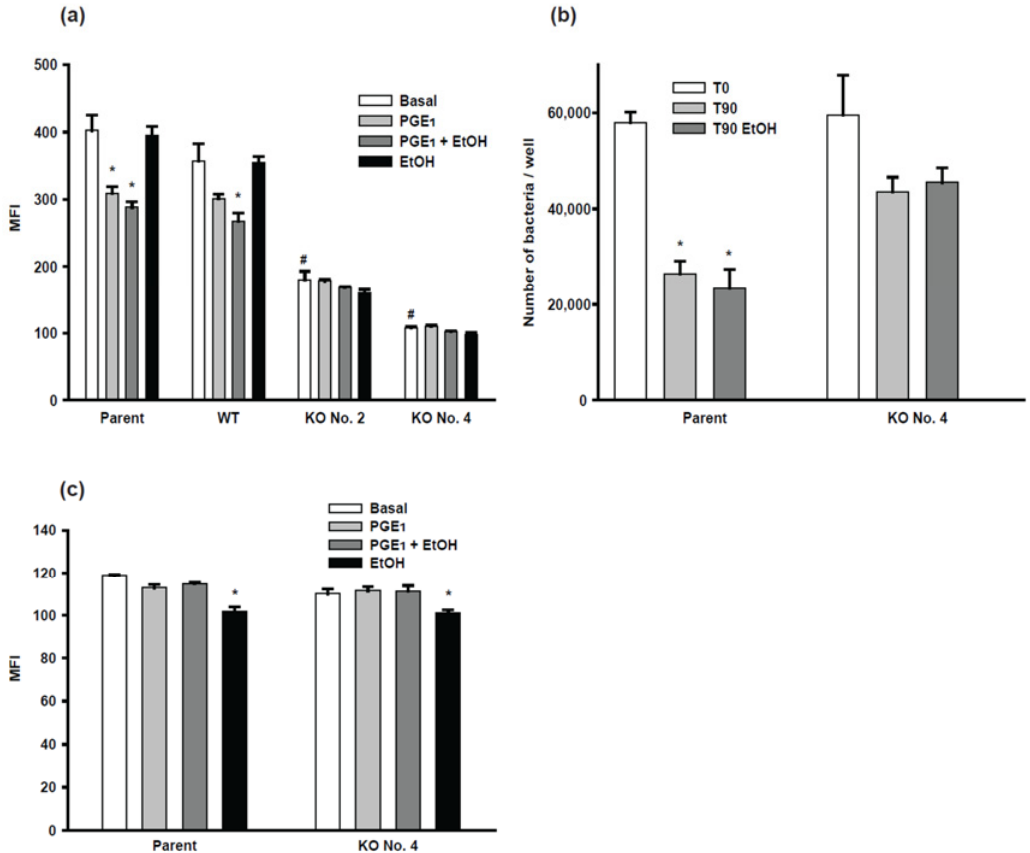
Figure 4. Effects of AC7 KO on phagocytosis, bacteria-killing, and oxidative burst of BV-2 cells. Assays are detailed in the Section 4 Materials and Methods. ( a ) Phagocytosis assay with parental cells, the WT clone, and two AC7 KO clones were carried out in the presence of no drugs (Basal), 10 µ M PGE 1 , 10 µ M PGE 1 plus 50 mM ethanol, or 50 mM ethanol. Data are presented as mean fluorescent intensity (MFI) and are represented as mean ± SEM in triplicate. * indicates the value is significantly smaller than the corresponding basal value. # indicates the value is significantly smaller than the basal value of parental cells at p < 0.05 using one-way ANOVA. ( b ) Bacteria-killing activity of the parental cells and one of the AC7 clones was measured by counting live bacteria before (T0) and after 90 min incubation (T90). One set of samples included 50 mM ethanol during the incubation (T90 EtOH). Data are represented as mean ± SEM in triplicate. * indicates the value is significantly smaller than the corresponding T0 value at p < 0.05 using one-way ANOVA. ( c ) Oxidative burst was measured under the basal condition, 10 µ M PGE 1 , 10 µ M PGE 1 plus 50 mM ethanol, or 50 mM ethanol. Data are presented as MFI and are represented as mean ± SEM in triplicate. * indicates the value is significantly smaller than the corresponding basal